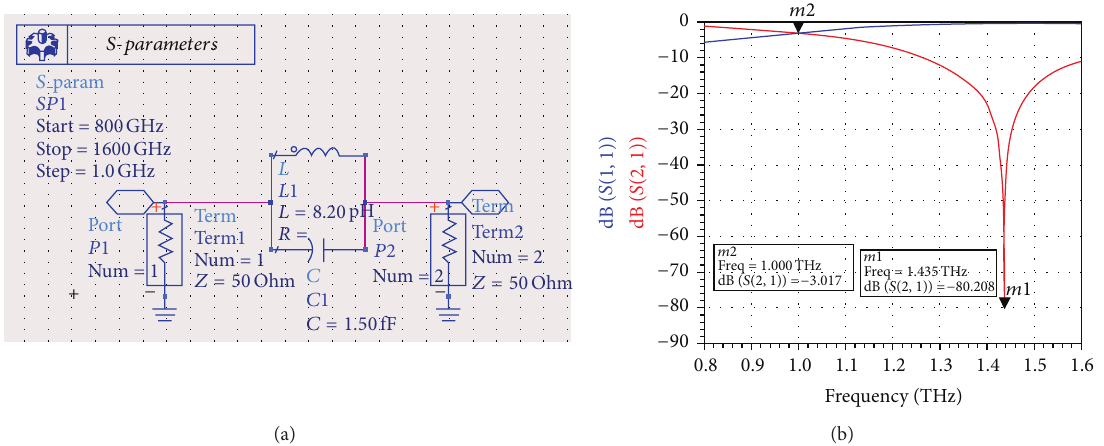
Figure 3: (a) 𝐿 - 𝐶 equivalent circuit model; (b) S-parameter characteristics by co-simulation in ADS